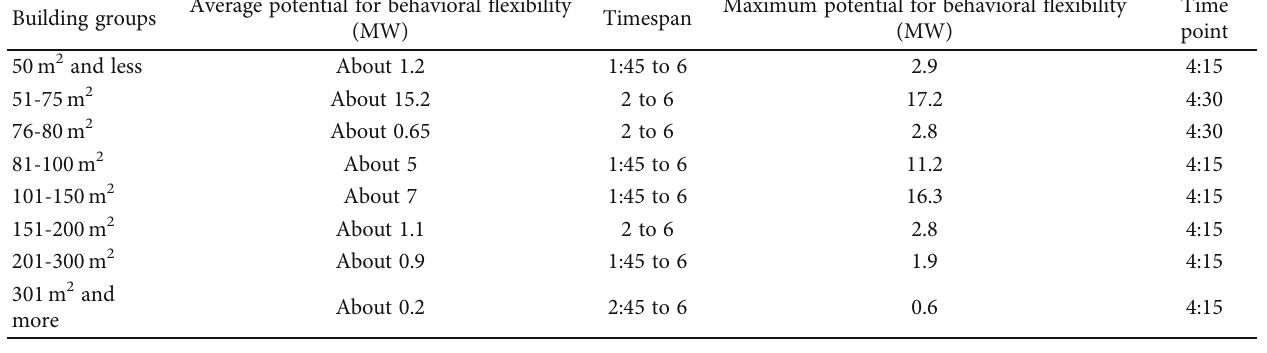
Table 12: Behavioral fl exibility potential of cooling energy consumption by di ff erent building groups (night).